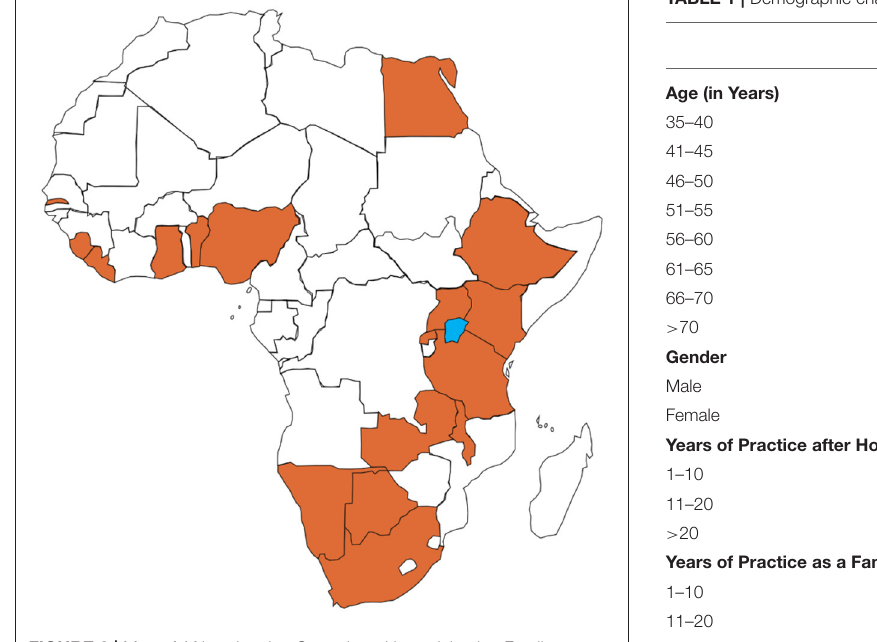
FIGURE 2 | Map of Africa showing Countries with participating Family Physicians.